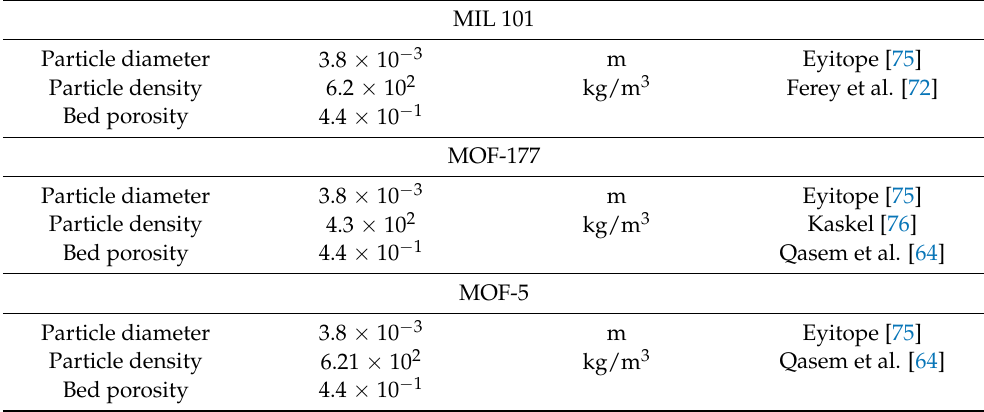
Table 4. Main data for